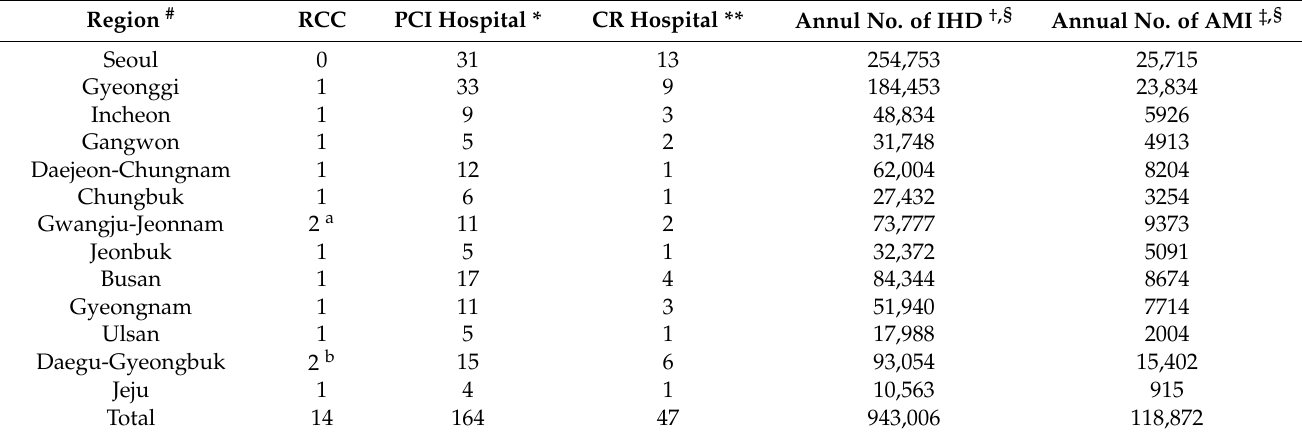
Table 2. Number and Distribution of Hospitals Performing PCI and CR by Region in Korea. Region